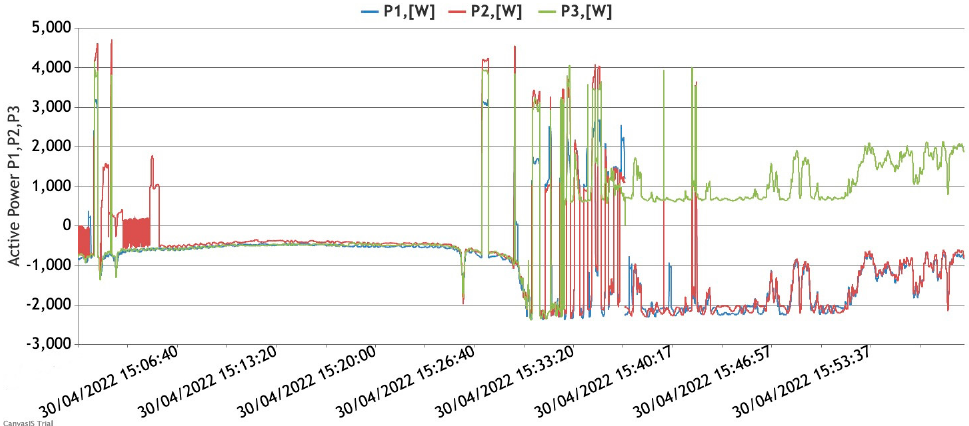
Figure 9. Power profile at connection point to the grid.